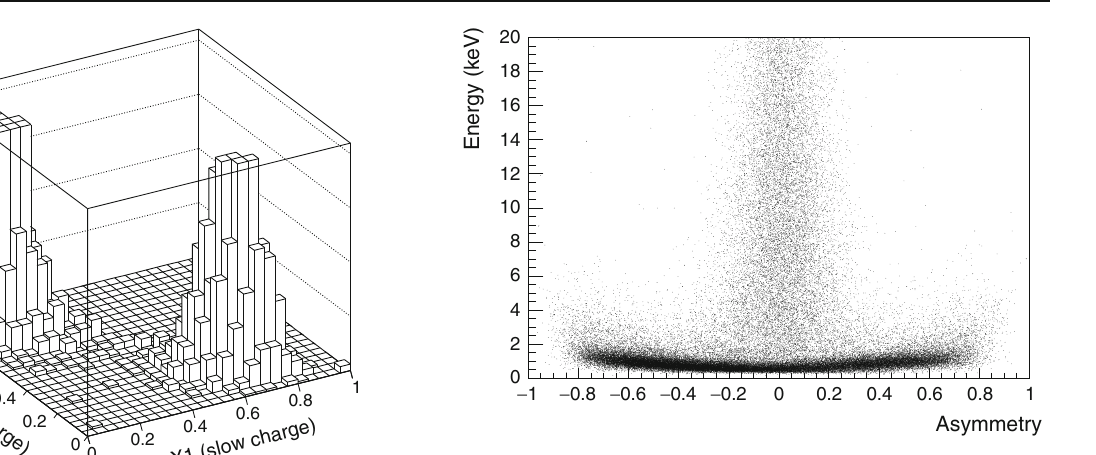
by placing a limit on the average number of SPEs per cluster.